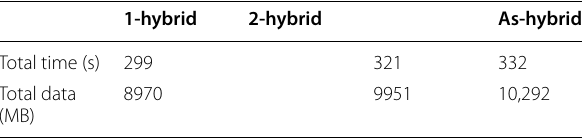
Table 4 Total migration time and transferred